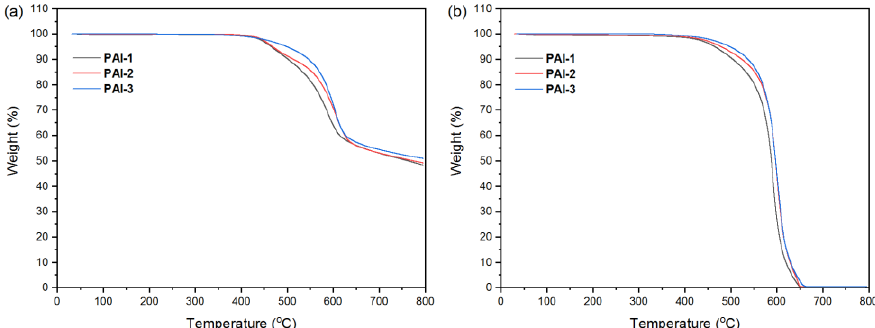
Figure 5. TGA curves of the PAIs in ( a ) nitrogen and ( b ) air at a heating rate of 10 °C/min.